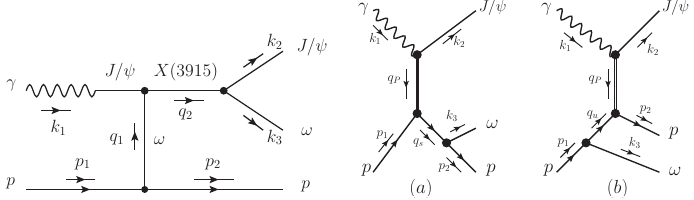
Figure 2. The energy dependence of the total cross sections for γ p → J /ψω p . Here, σ Pom and σ ω are the results only considering the Pomeron exchange and the ω exchange contributions, respectively, while σ T denotes the total cross section of γ p → J /ψω p . We also give the variations of σ ω and σ T to corresponding to the typical values Γ ( X (3915) → J /ψω ) = 0 . 15 MeV, Γ ( X (3915) → J /ψω ) = 1 . 7 MeV and Γ ( X (3915) → J /ψω ) = 5 . 1